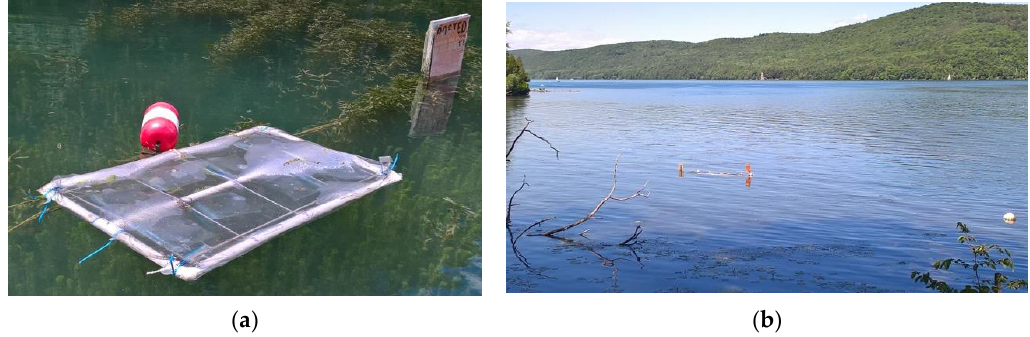
Figure 1. ( a ) Experimental mesocosms. ( b ) Deployment site.